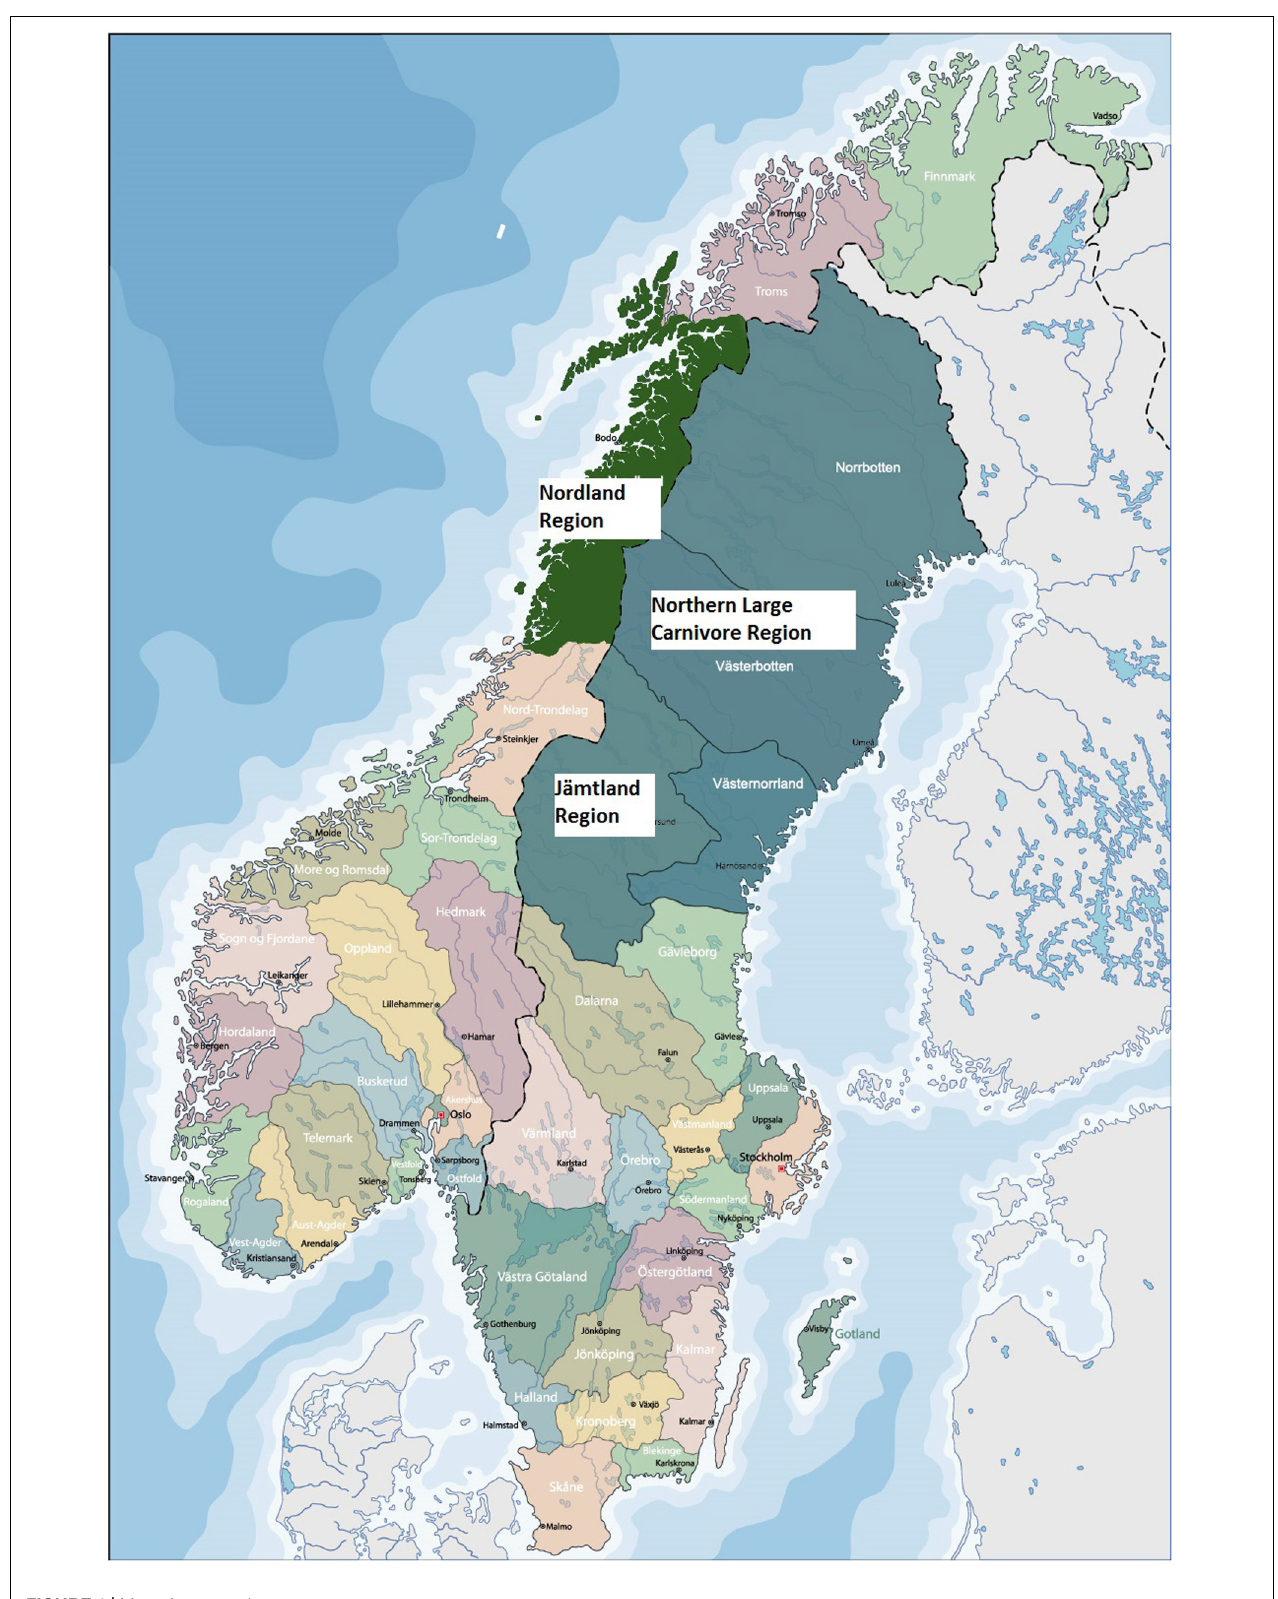
FIGURE 1 | Map of case study